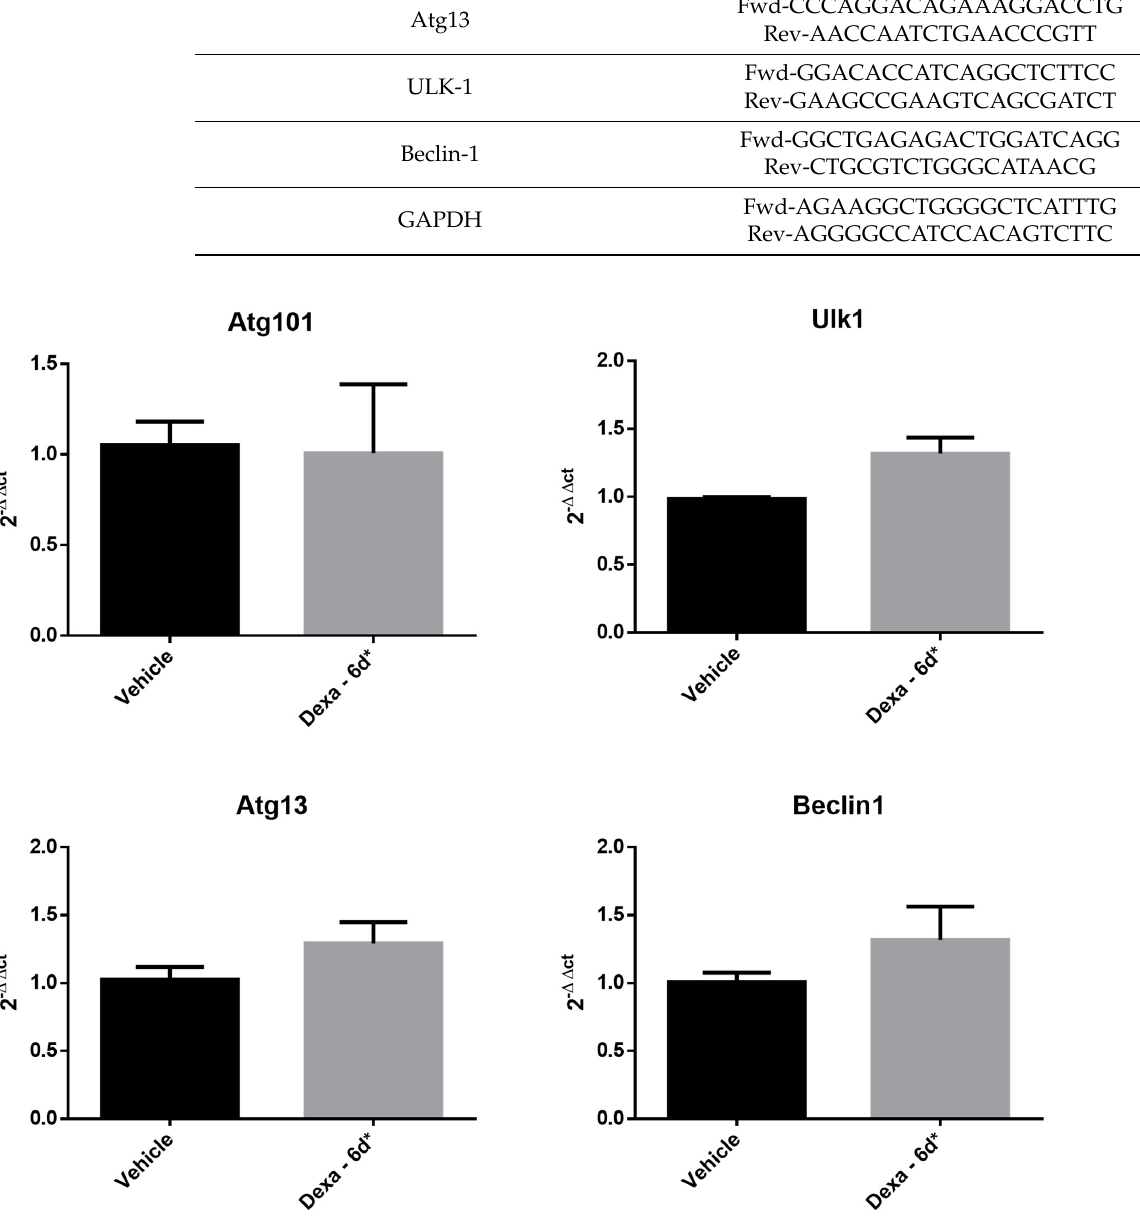
Figure 6. Autophagy gene expression analysis of Dexa-treated TMCs. RT-PCR results of the expression of ULK-1, ATG101, ATG13, and Beclin-1. Gapdh was used as internal control, as indicated in the Section 4. Data are reported as fold-increase with respect to control group. The 2 - ΔΔ Ct formula was used to calculate the fold-increase versus vehicle cells.